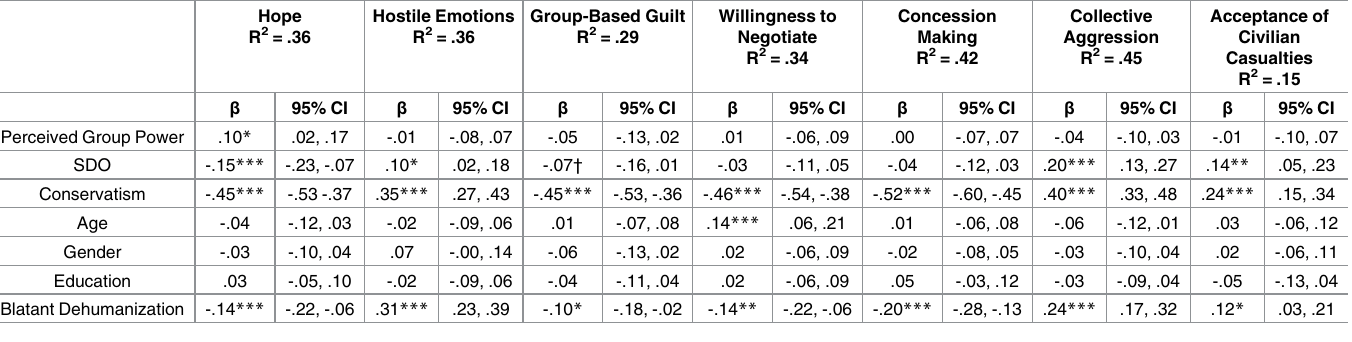
Table 2. Simultaneous regressions predicting outgroup attitudes as a function of political ideology and dehumanization in Study 1. Hope R 2 =